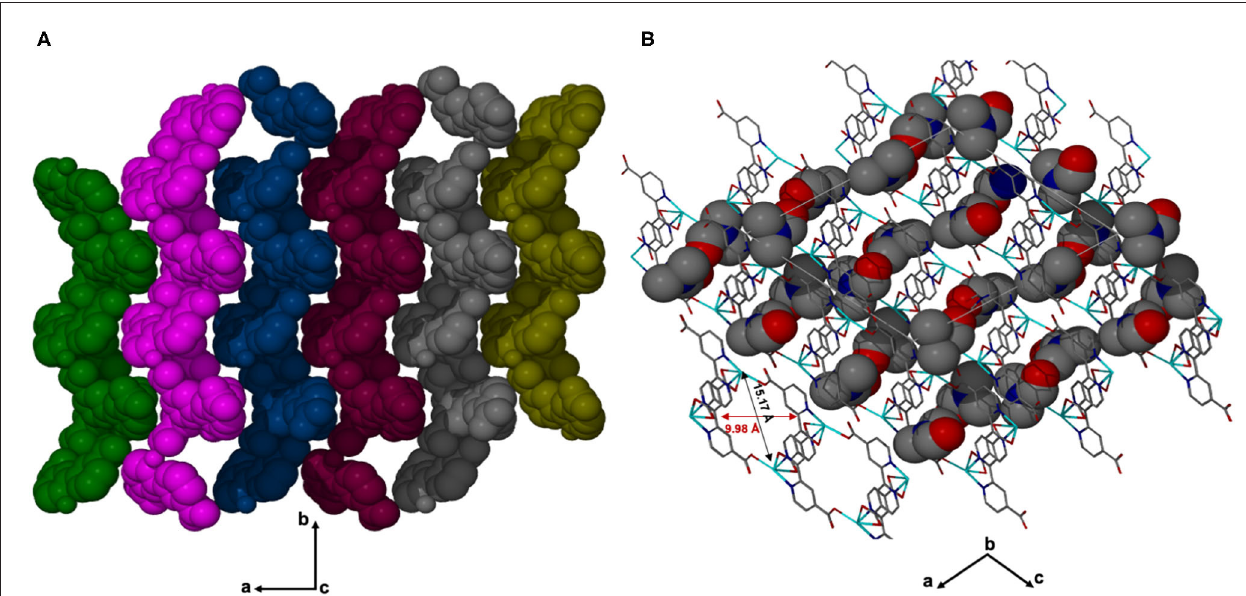
FIGURE 2 | (A) Structure of JMS-3 displaying interdigited channels, viewed along c -axis. (B) The 2D network of JMS-3 guest molecules are drawn with van der Waals radii.